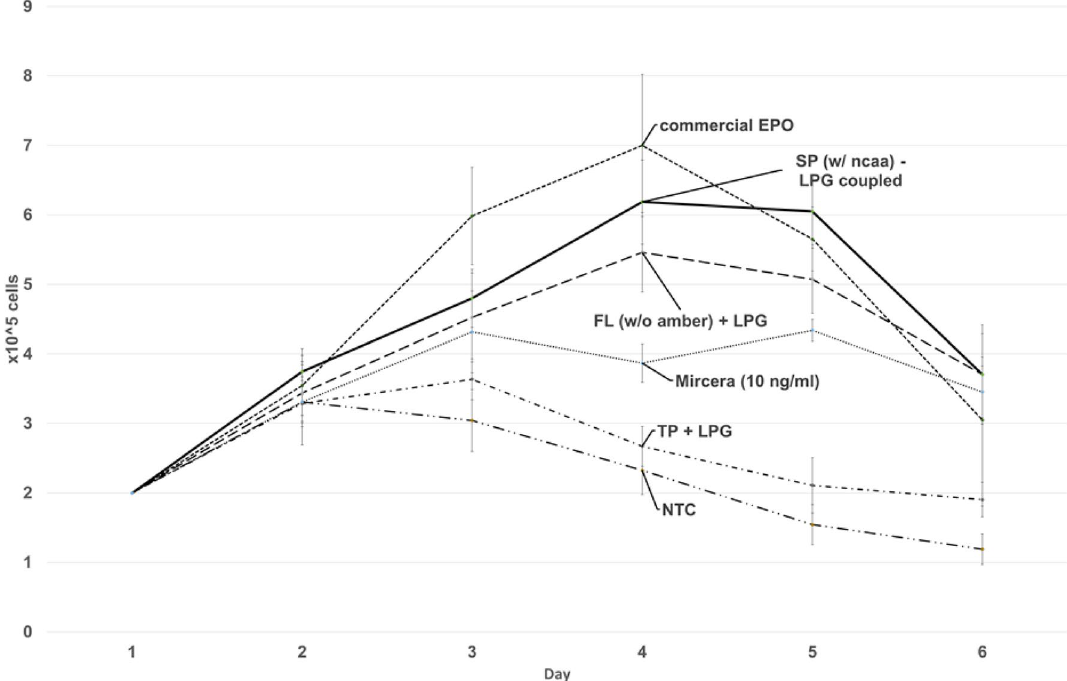
Figure 4. Cell-based activity assay of LPG-modified and non-modified cell-free synthesized EPO. Growth curves of TF-1 cell-line supplemented with LPG-modified EPO (continuous line), non-modified EPO (dashed line), termination product (dashed-single-dot line) cell-free no template control (NTC, dashed-double-dot line), commercial EPO (dashed line) and commercial Mircera® (grey dashed line). Concentrations of cell-free synthesized EPO variants were determined by TCA precipitation. 10 ng/mL of each sample was added to the TF-1 cells cultured in a 24-well-plate. Cells were counted for 6 days. Data are presented as the standard deviation of three independent experiments measured in duplicates (n = 3).